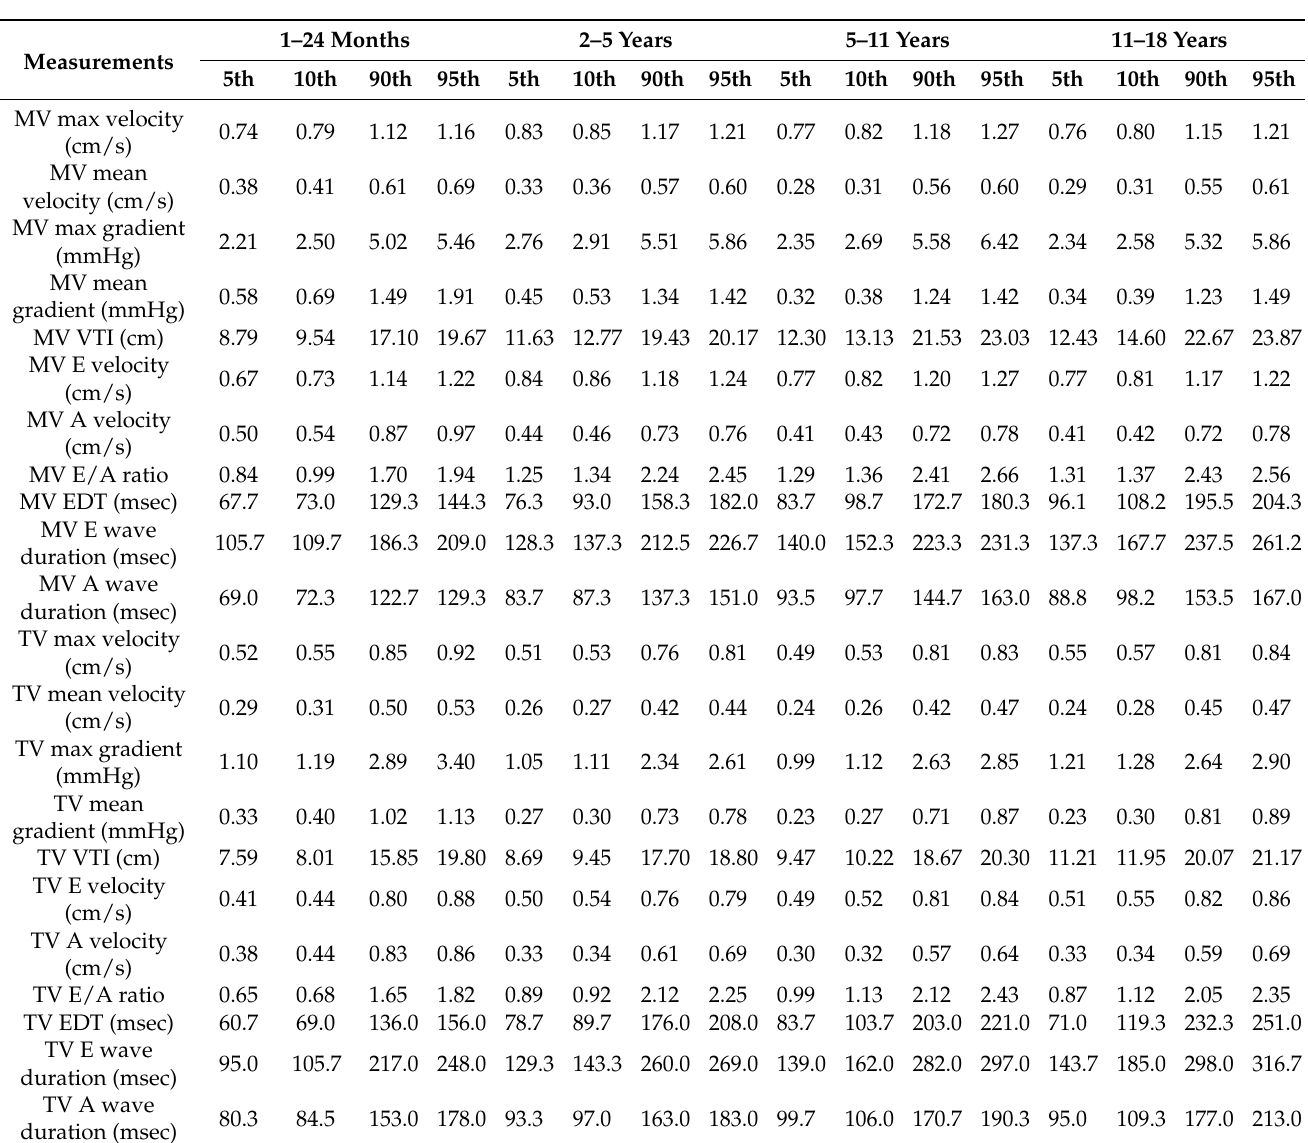
Table 3. Mitral (MV) and tricuspid valve (TV) Doppler values in healthy subjects: percentile mea- surements per age